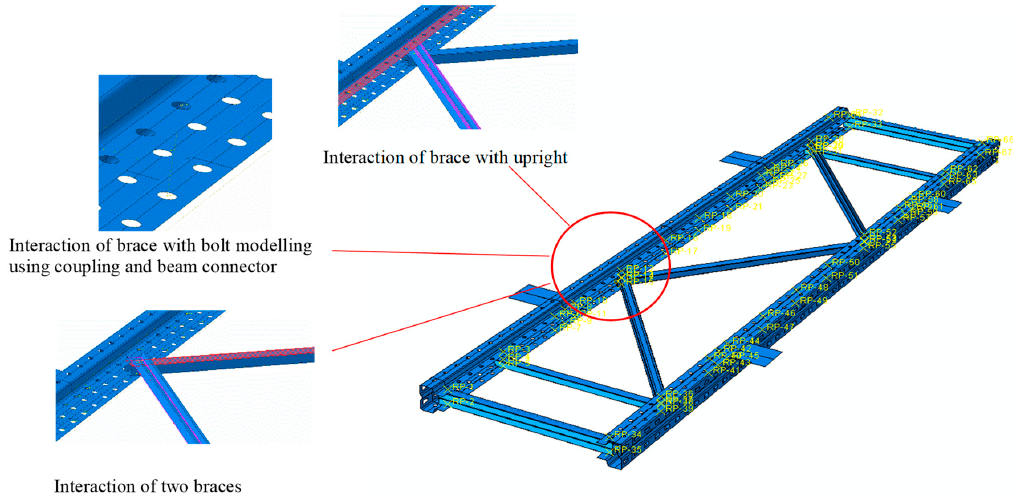
Figure 24. Interactions of the model components and bolt modelling.